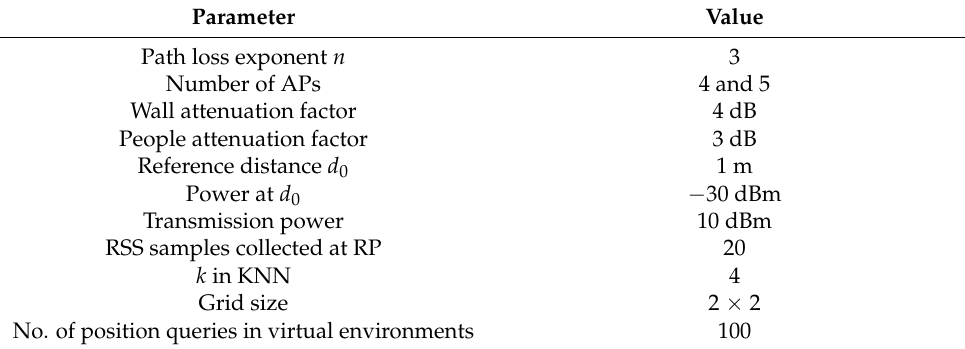
Table 2. Parameters used in